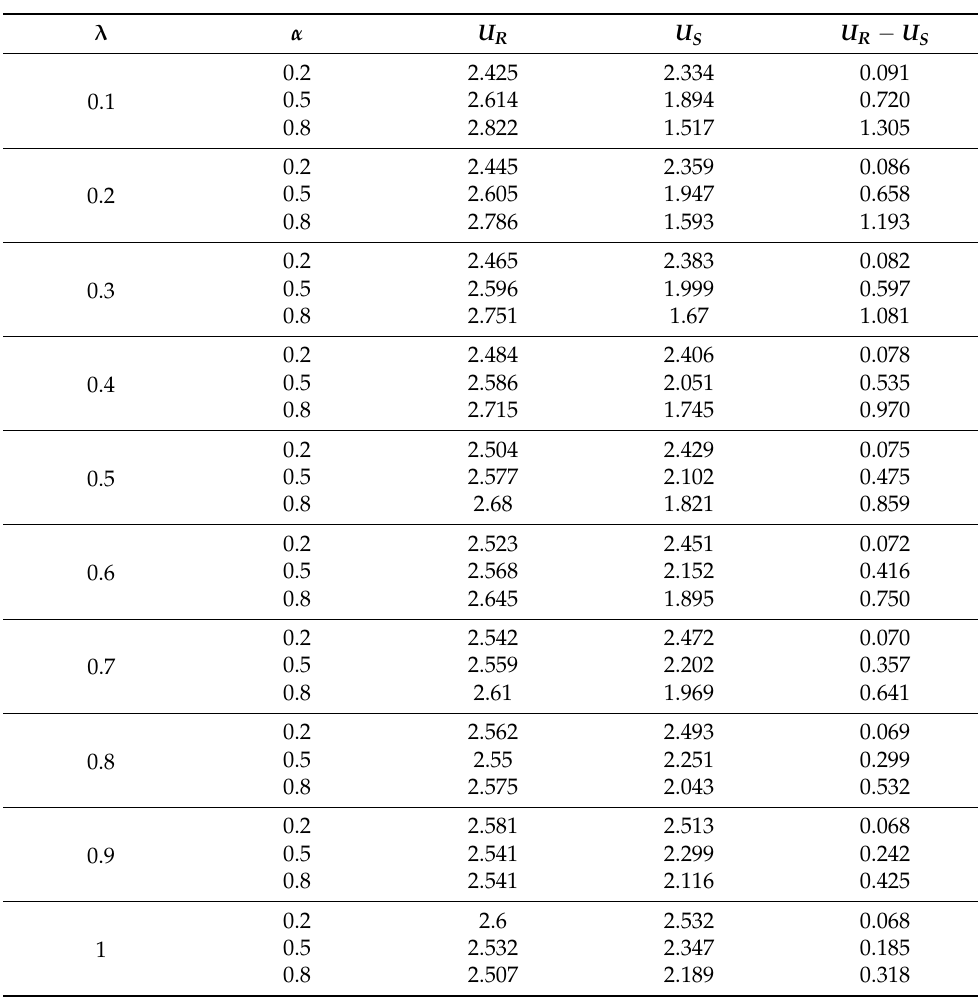
Table 3. Comparison of the utility of the supply chain under adverse unfair aversion of distributors and